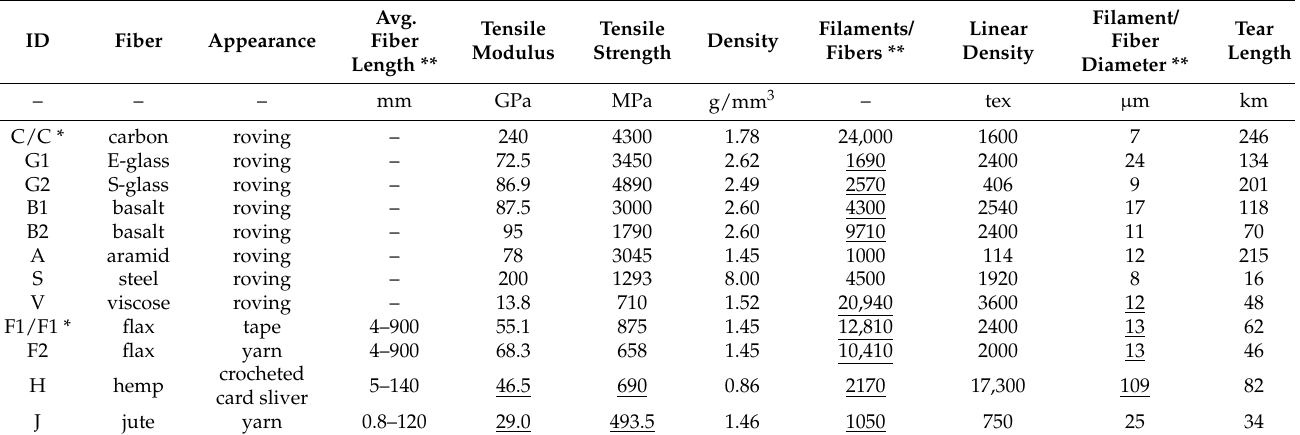
Table 2. Overview of the selected fiber materials.